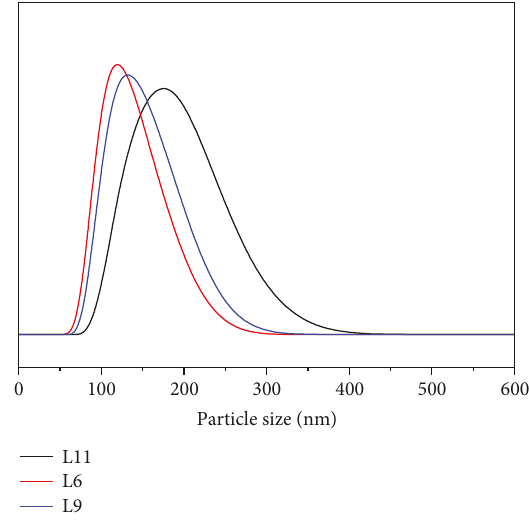
Figure 2: Particle size distribution of di ff erent latex